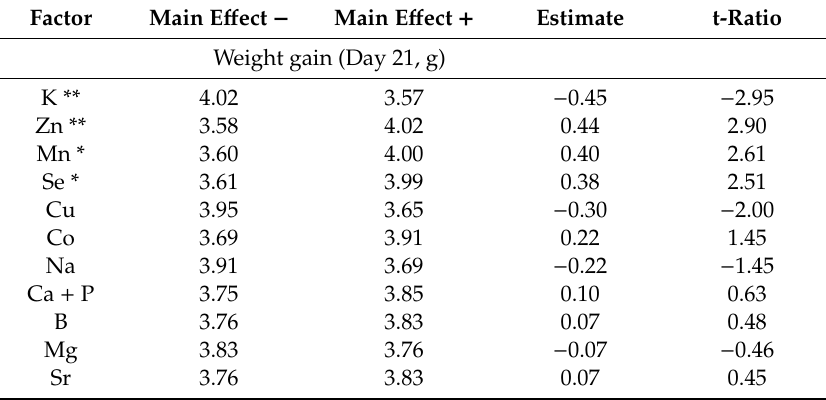
Table A1. E ff ect of twelve dietary minerals at two inclusion levels ( − /+ ) on weight gain (g) at Day 21 and 42, moulting frequency (g / week), biomass gain (g) and survival (%) at Day 42 using two-level screening analysis. Factors are sorted by | estimates | and significant factors are marked by an